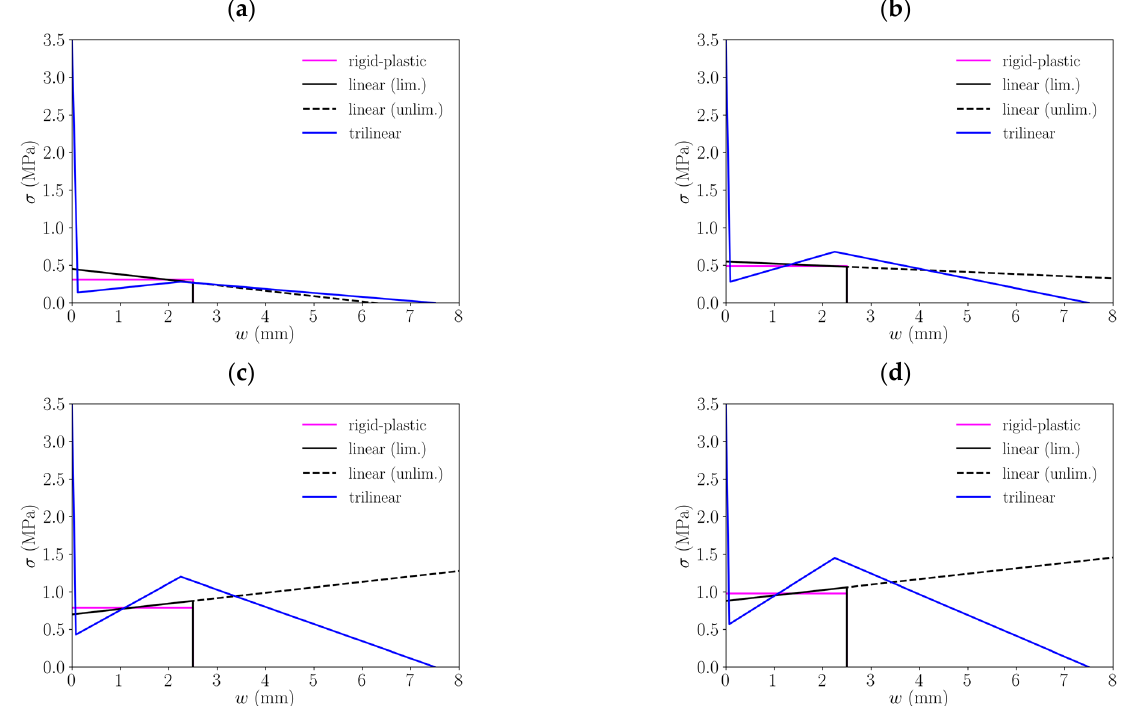
Figure 5. Comparison of the constitutive models obtained by each approach for different fibre dos- ages: ( a ) 3 kg/m³, ( b ) 4.5 kg/m³, ( c ) 6 kg/m³, ( d ) 10 kg/m³. dosages: ( a ) 3 kg/m 3 , ( b ) 4.5 kg/m 3 , ( c ) 6 kg/m 3 , ( d ) 10 kg/m 3 .